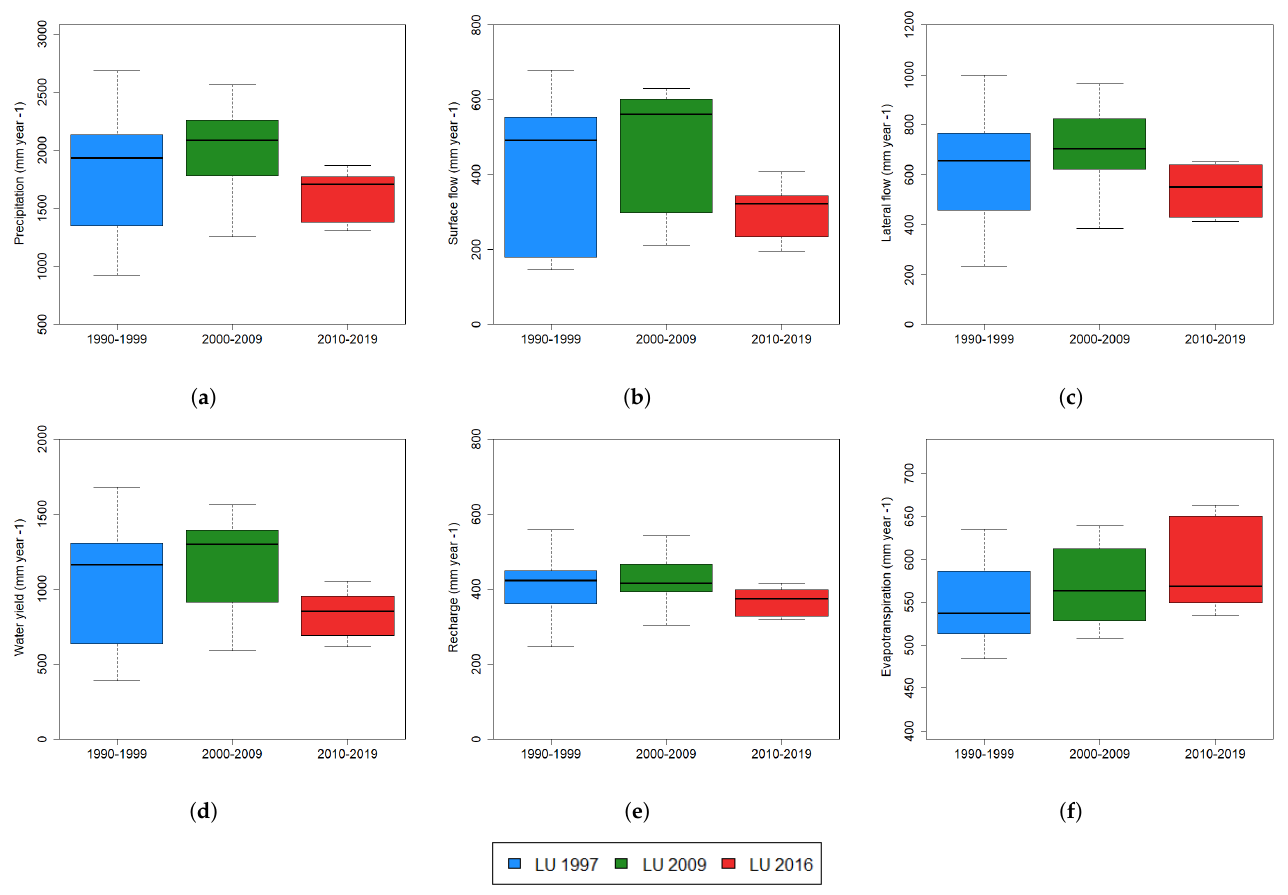
Figure 7. Annual average by decades under LU 1997 (1990–1999), LU 2009 (2000–2009), and LU 2016 (2010–2019) for the parameters: ( a ) Precipitation, ( b ) Surface flow, ( c ) Lateral flow, ( d ) Water yield, ( e ) Recharge, and ( f ) Evapotranspiration. Table 9. Annual average (Mean) and coefficient of variation (CV) by decades for PRECIP, SURQ, LATQ, WY, RCHRG, and ET under LU 1997, LU 2009, and LU 2016 for the studied period. Values are expressed as mm year − 1 and %,